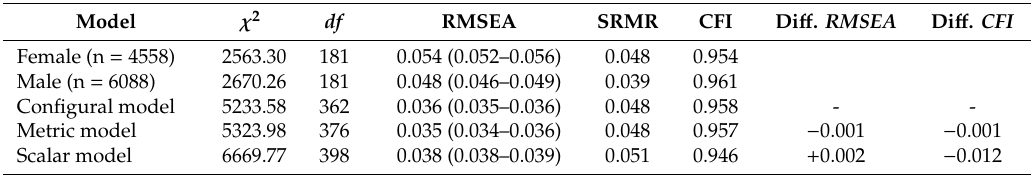
Table 3. Analysis of invariance across gender groups.